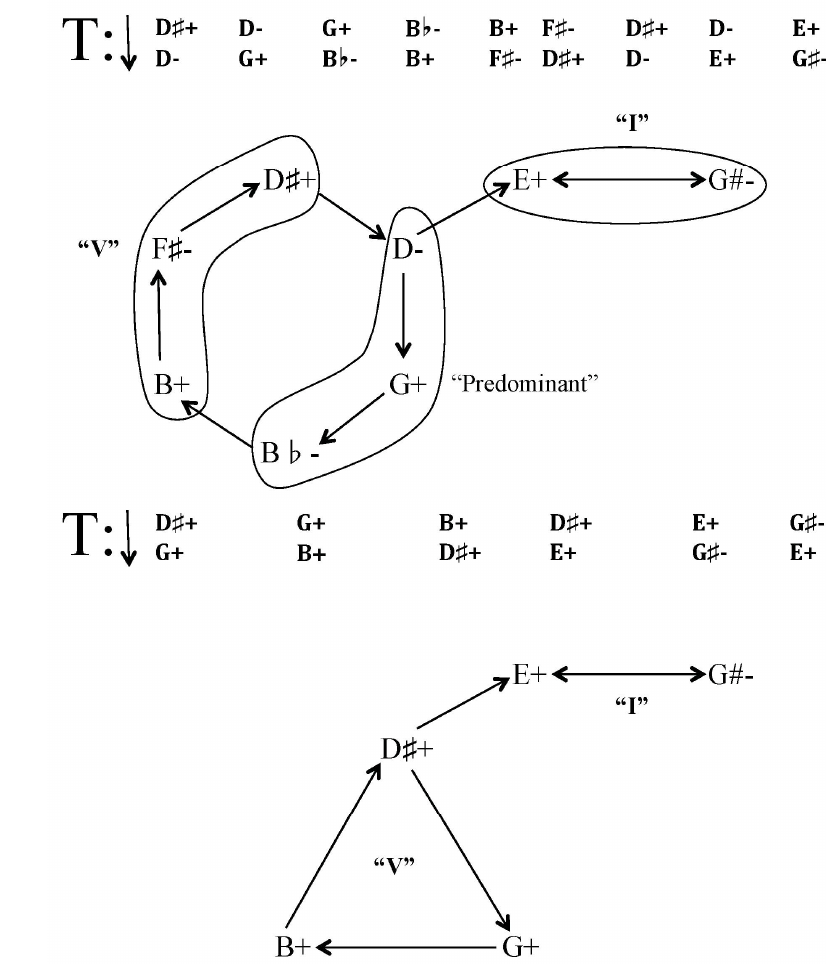
Figure 12. Kinematic analysis of Figure 5. ( a ) Eight ‐ note line of both “real” and “assumed” chords; ( b ) five ‐ note line of chords that actually appear in score.